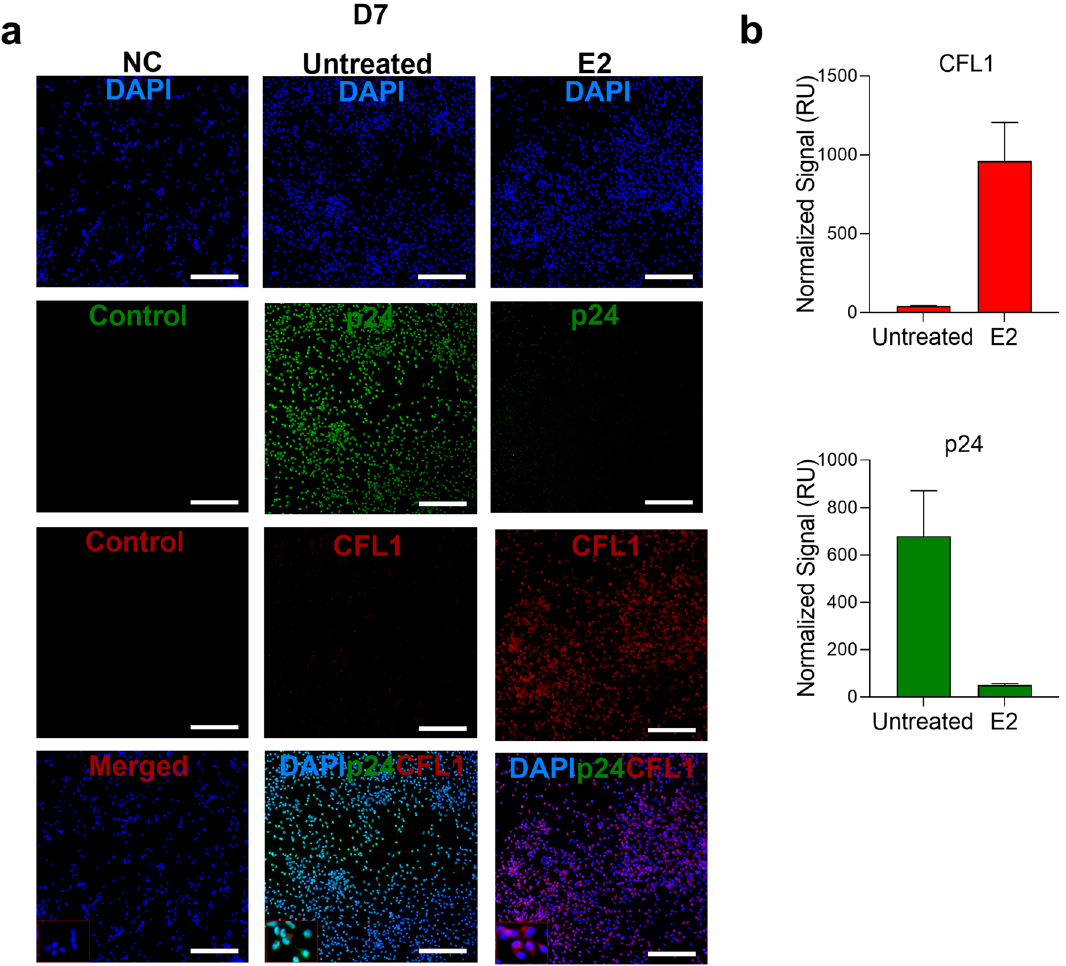
were used as a NC for p24 staining. Single experiment representative of 3 experiments is shown (original magnification 20X; scale bar is 100 μm). (b) Shown is the normalized fluorescence intensity of CFL1 and p24 staining in relative units (RU) (Mean ± SEM; 3